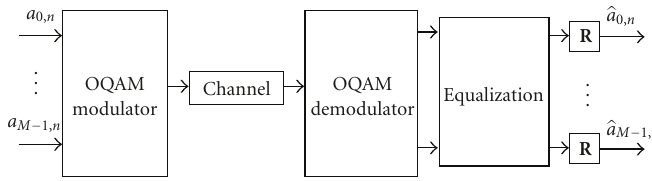
Figure 2: The transmission scheme based on